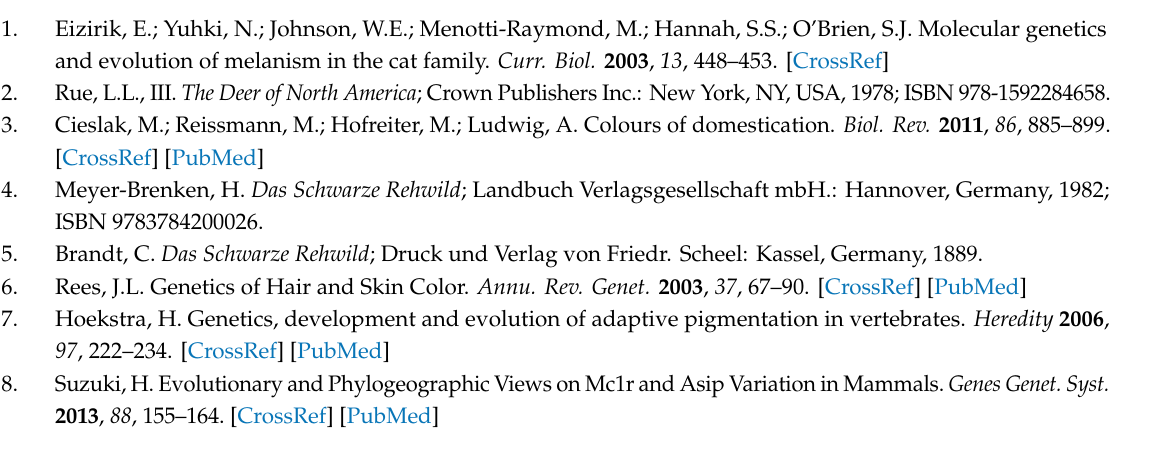
Figure S1: Alignment of MC1R based on European roe deer sequences from the whole genome sequencing, the GenBank sequence, the chestnut and the black roe deer. Figure S2: Alignment of ASIP based on sequences of the European roe deer from the whole genome sequencing, a chestnut and a melanistic individual, and the equine mRNA sequence. Table S1: Table of origin, coat color phenotype and genotype for SNPs for 495 European roe